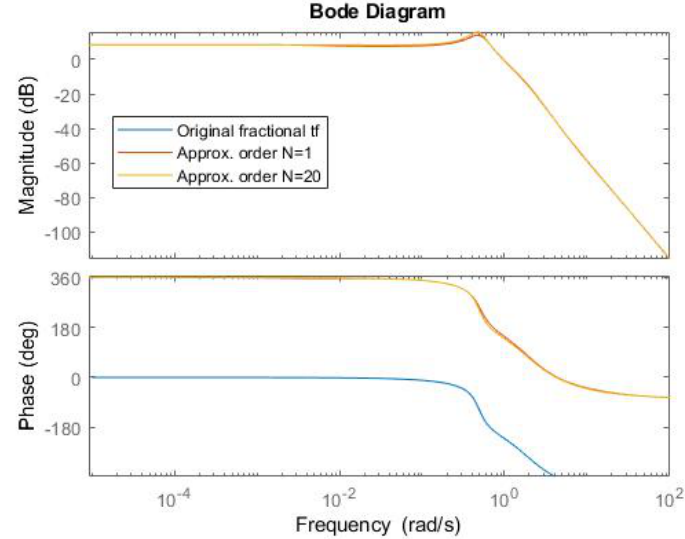
Figure 17. Comparison of Bode diagrams for the Oustaloup filters.